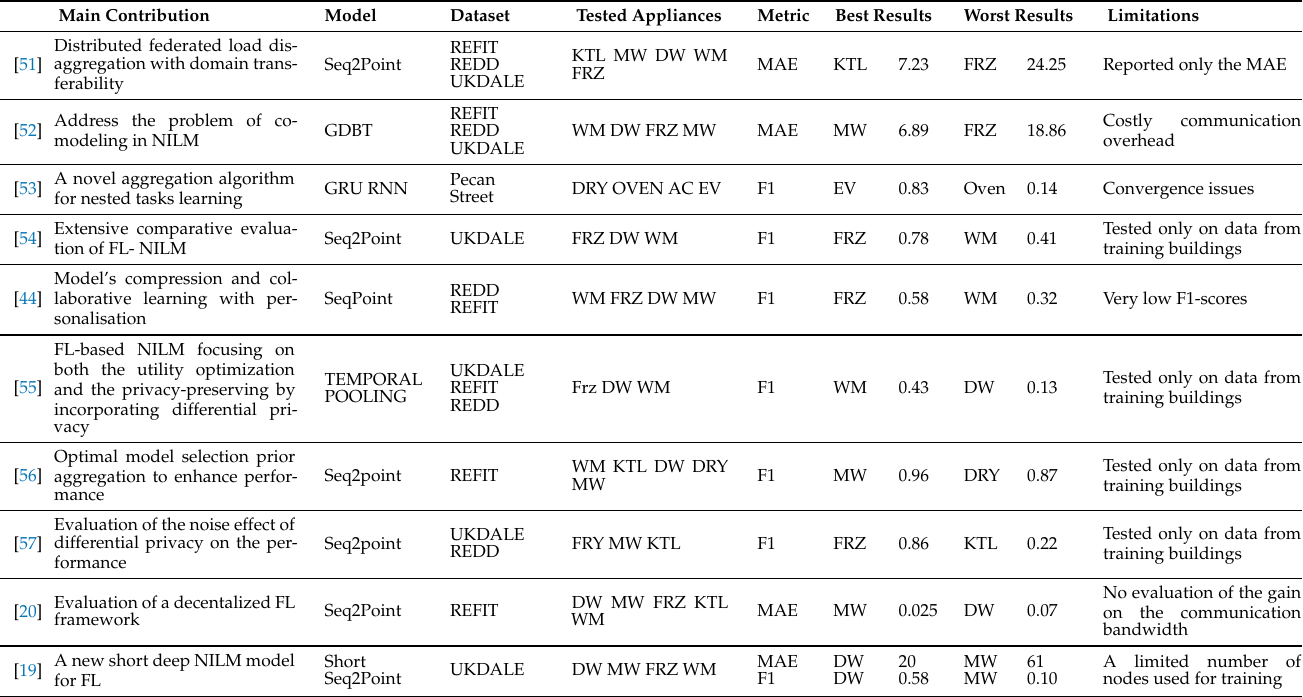
Table 3. FL frameworks for residential load